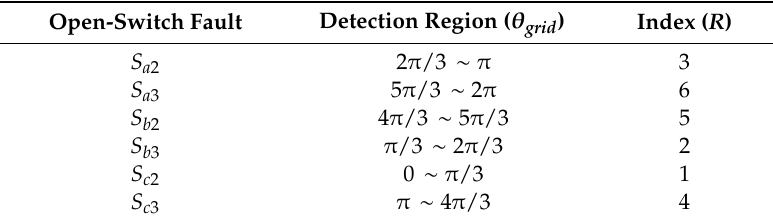
Table 2. Detection region and index on open-switch fault.